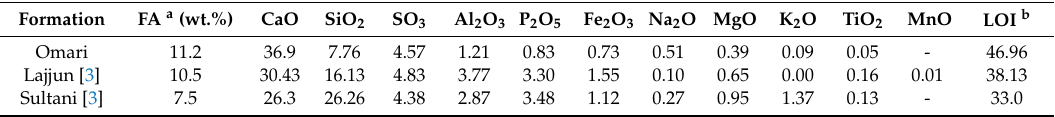
Table 2. X-ray fluorescence (XRF) analysis (wt.%) of the tested oil shale sample “as received” from the Omari formation in comparison to samples from Lajjun and Sultani